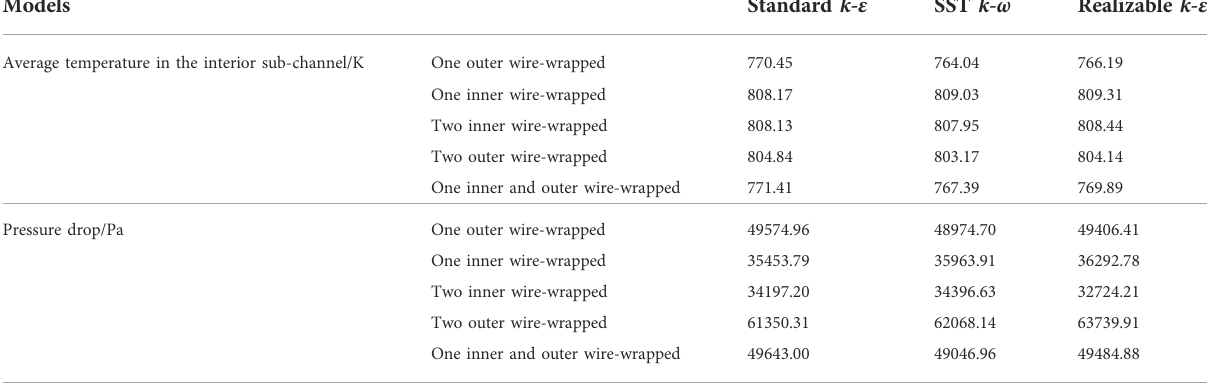
TABLE 3 Flow and heat transfer characteristics with different turbulence models.